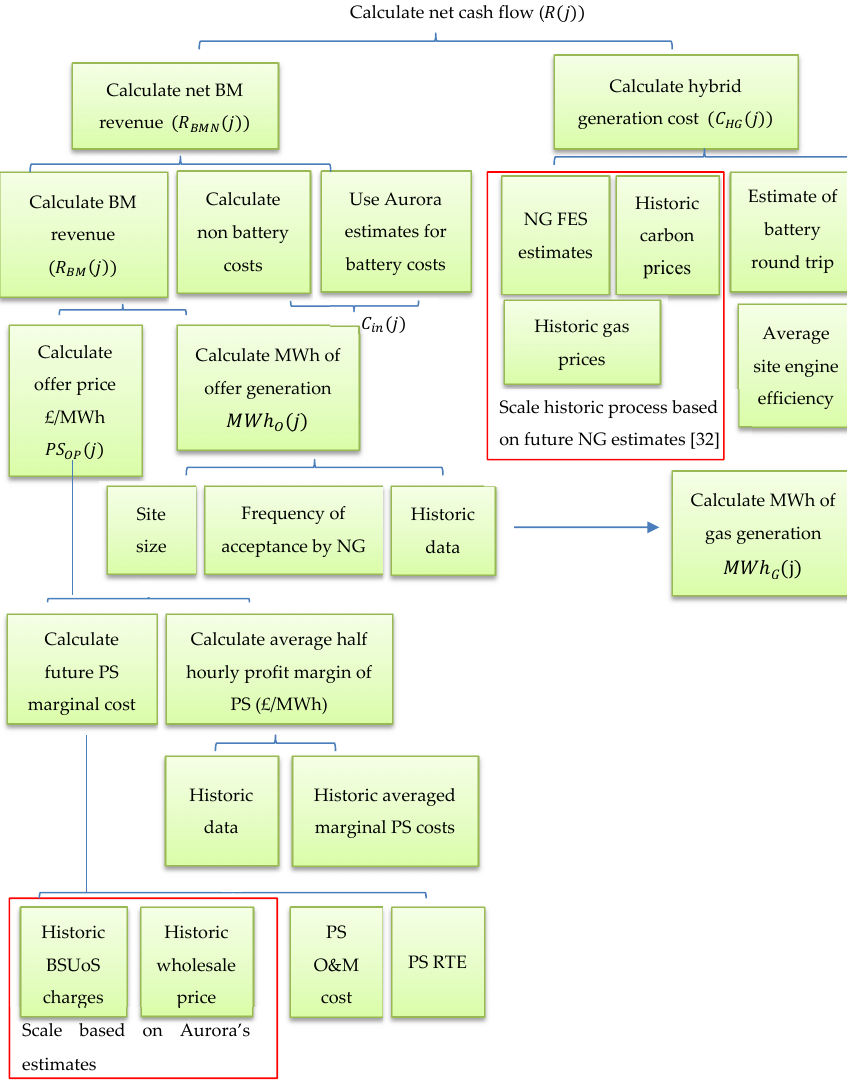
Figure 8. Example operation—case 2.